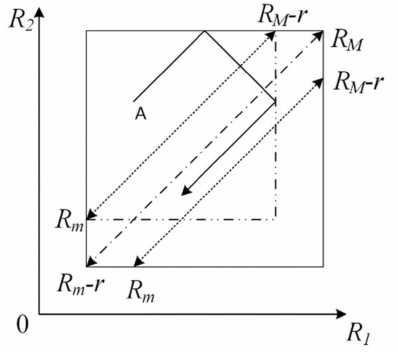
Figure 6. Phase plane for two coupled